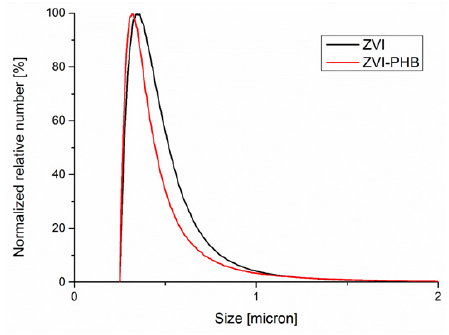
Figure 5. Particle size distribution of bare ZVI and ZVI–PHB composite samples (ZVI/PHB ratio 1:2 w / w ).